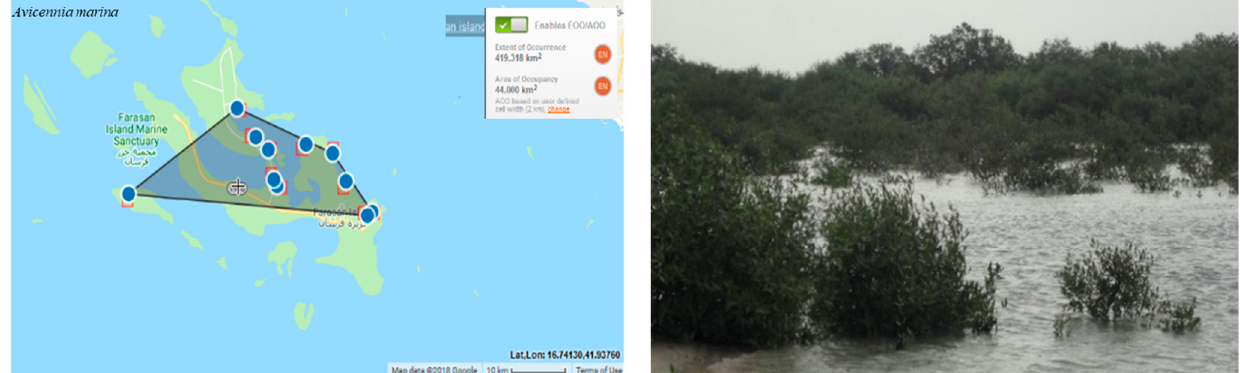
Figure 3. Geographical distribution of Avicenna marina in the Farasan Archipelago. Al-Qthanin from Faranan Alkabir